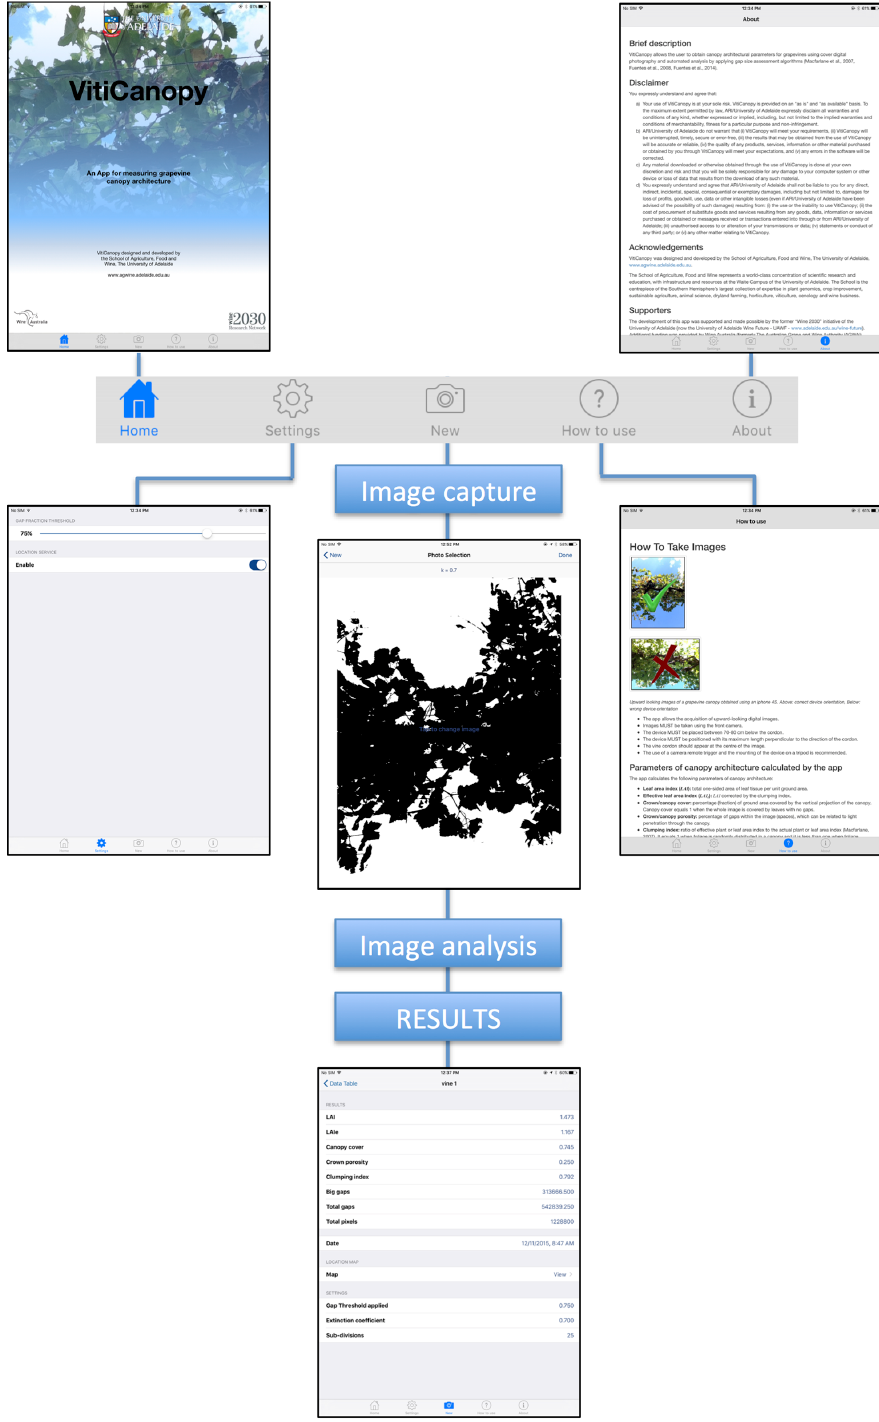
Figure 2. VitiCanopy Home page displaying the five main menu tabs as a simplified operations flow chart.